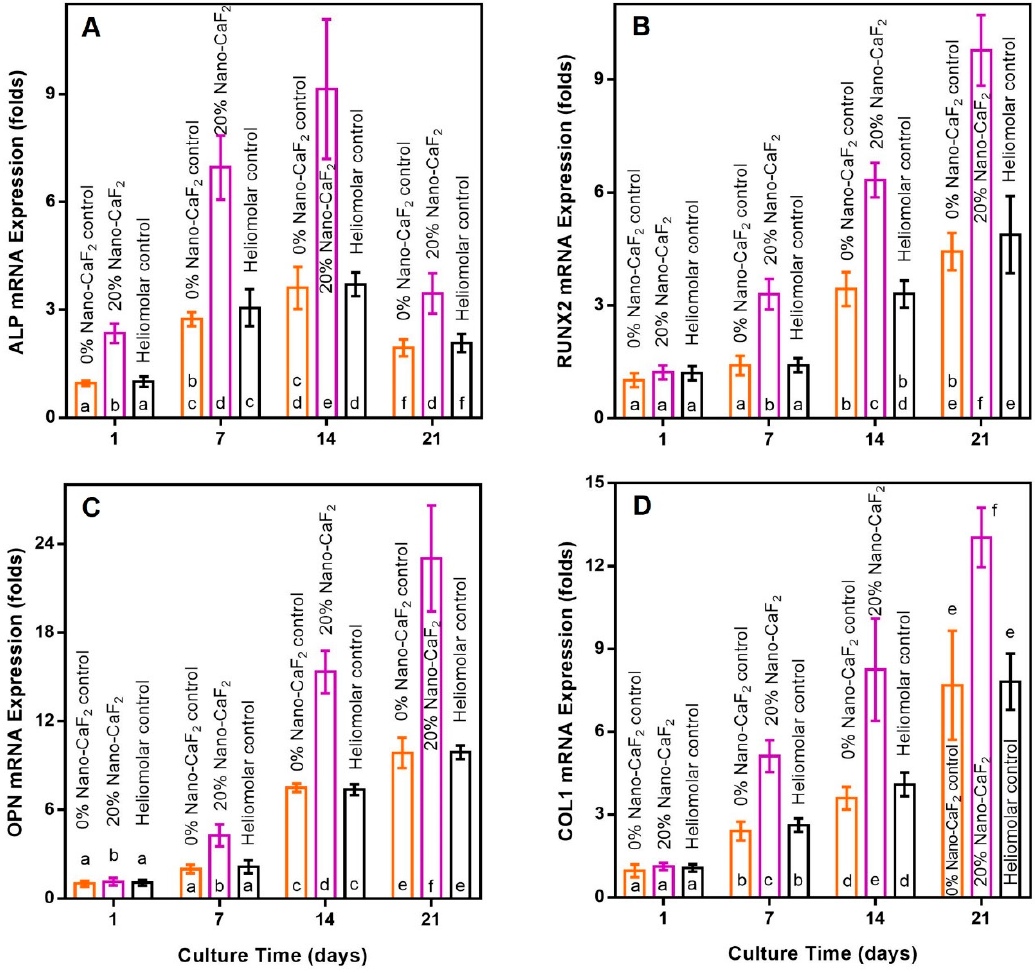
Figure 5. The expression of osteogenic genes of hPDLSCs growing on composites. The ALP gene expressions ( A ) peaked at 14 days, and RUNX2 ( B ), OPN ( C ) and COL1 ( D ) peaked at 21 days. Values with dissimilar letters such as a and b are significantly different ( p < 0.05, mean ± SD; n = 6).